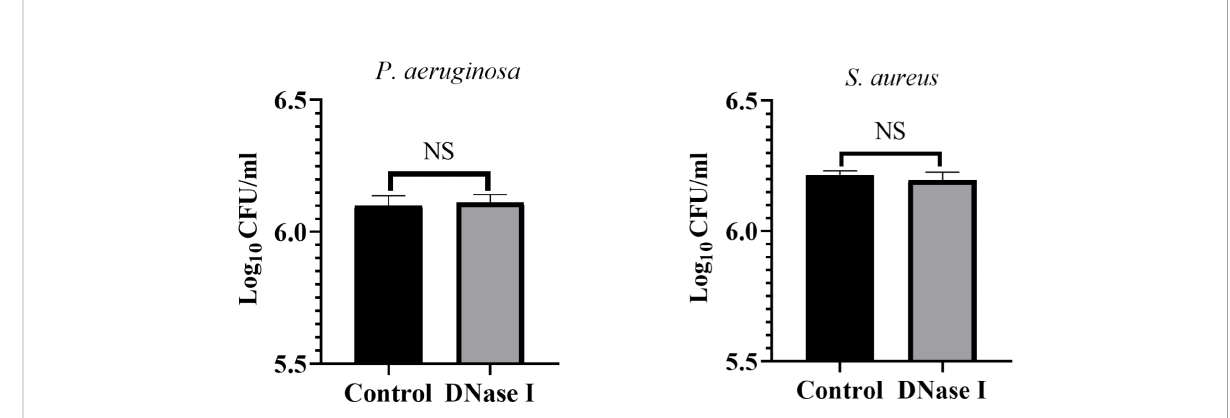
FIGURE 10 Colony counts of the indwelling catheters. Colony counts of P. aeruginosa or S. aureus on the surface of the indwelling catheters in the two rabbit groups. The results are presented as mean ± SD. NS indicates a p value > 0.05, compared with the values in the drug-free control group using t -tests (n = 4).